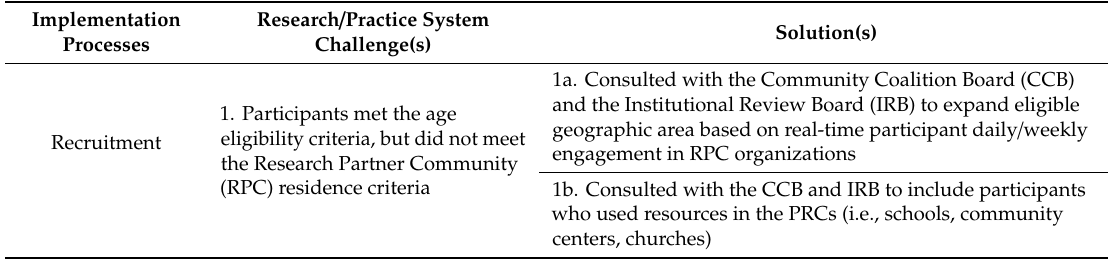
Table 1. Research / Practice Systems Challenges and